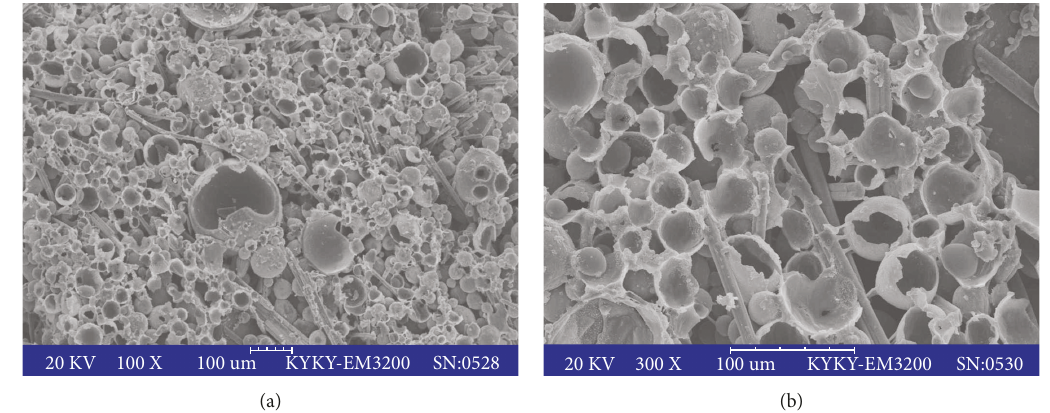
Figure 5: Microstructure image of the carbonized layer of ablative thermal insulation material: (a) 100 times magni fi ed image and (b) 300 times magni fi ed image.